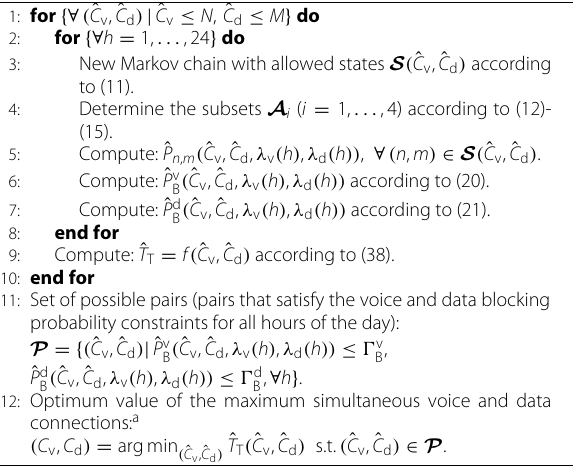
Table 1 Network dimensioning methodology (configuration #1)